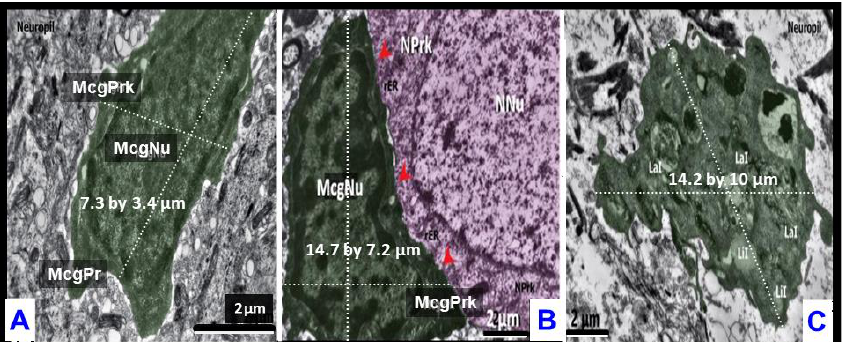
Figure 7. Hypertrophic-like and gitter cell-like microglia were at least twice the size of surveilling control microglia. Panel ( A ) demonstrates the typical morphology of the surveilling control microglia with measurement bars measuring 2 μ m per scale bar (previously Figure 3A). Panel ( B ) depicts the hypertrophic-like microglia with measurement scale bars measuring 2 μ m (previously Figure 6E). Red arrowheads represent the microglia neuronal perikaryon interface. Panel ( C ) depicts only a partial portion of the cytoplasm (previously Figure 5C). Note that the hypertrophic-like microglia and the cytoplasmic portion of the gitter cell-like microglia in panels ( B , C ) respectively were almost twice the size of the surveilling control microglia in panel ( A ). Scale bar 2 μ m; however, note that the scale bar in panel ( A ) is almost twice as long as scale bar in panels ( B , C ). Surveilling control microglia measured approximately 7.3 by 3.4 μ m. In contrast, the hypertrophic-like microglia measured approximately 14.7 by 7.2 μ m and the cytoplasmic portion of the gitter – like microglia measured approximately 14.2 by 10 μ m in panels ( B , C ), respectively. Thus, the cells depicted in panels ( B , C ) measured almost twice the size of the control surveilling microglia. LaI = lamellar inclusions; Lit = lipid inclusions; McgPr = microglia process; McgPrk = microglia perikaryon; McgNu = microglia nucleus; N Nu = neuronal nucleus; NPrk = neuron perikaryon.